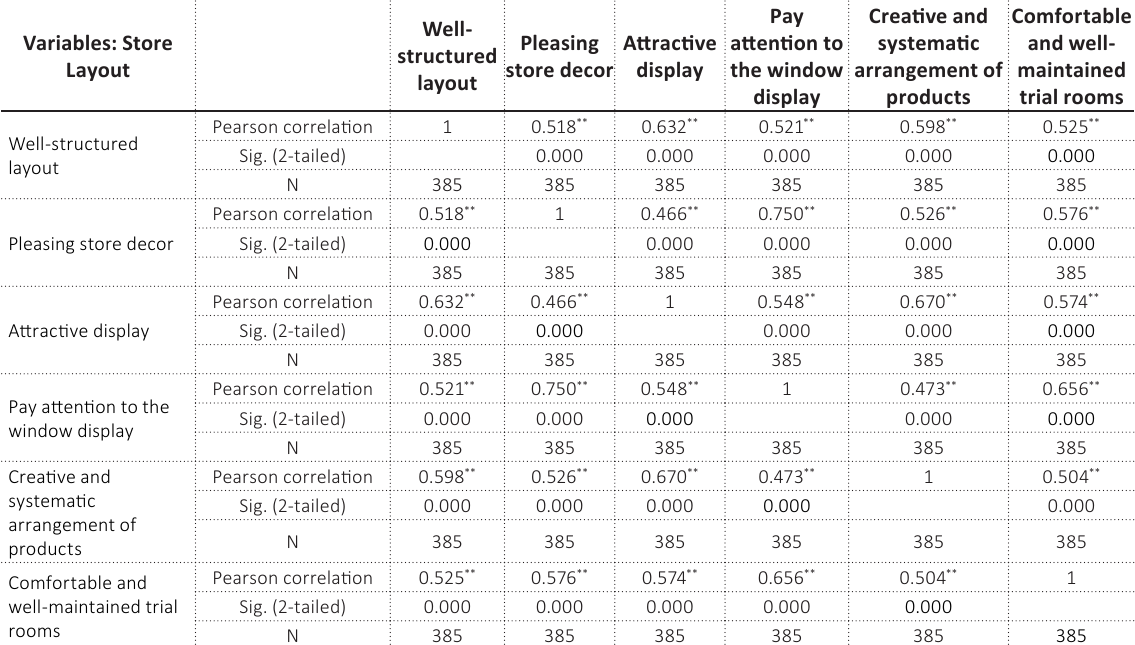
Table 1. Correlation between the variables of store layout Variables: Store